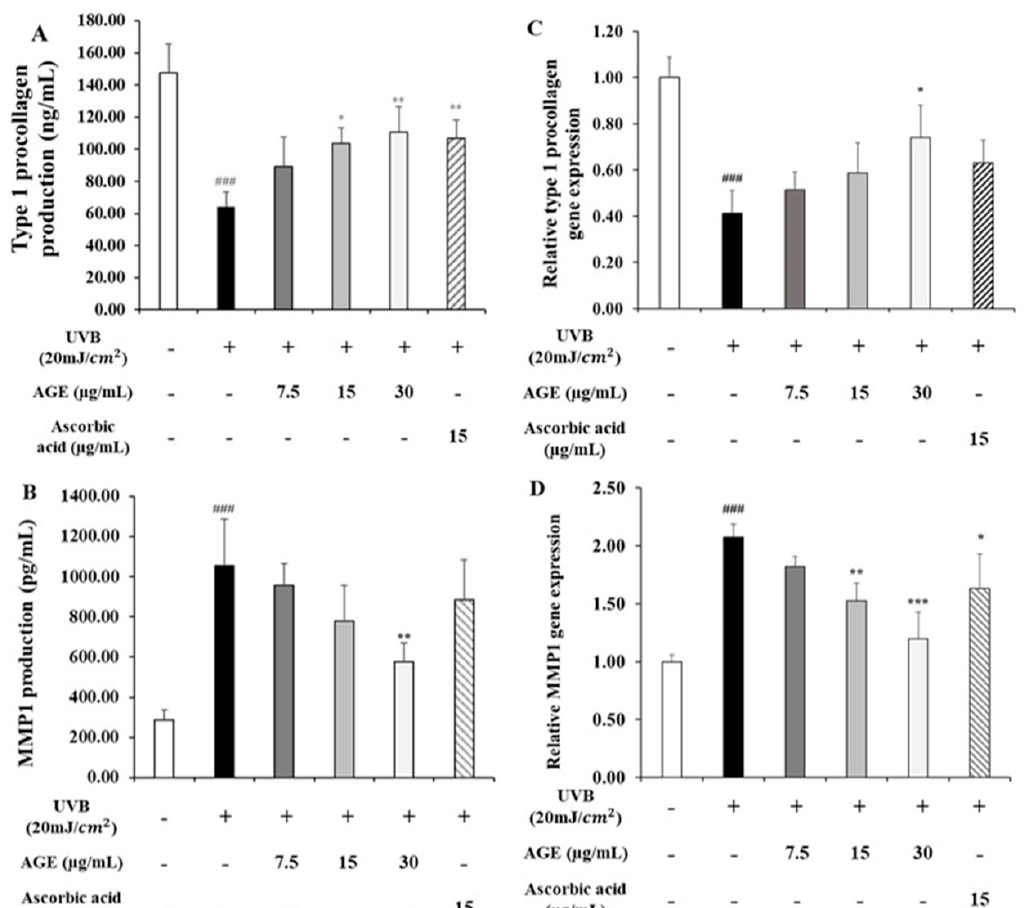
Figure 3. Effect of AGE on type I procollagen and MMP-1 level in UVB-irradiated HDFs. HDFs were irradiated with UVB (20 mJ/cm 2 ), followed by treatment with 7.5, 15, and 30 µ g/mL of AGE. After 24 h of incubation, detection of type I procollagen ( A ) and MMP-1 ( B ) production were performed by using ELISA kits. Gene expression of COL1A1 ( C ) and MMP-1 ( D ) were determined by quantitative real-time (qRT)-PCR. All data were expressed as the mean ± SD of at least three independent experiments. ### p < 0.001 versus untreated cells, * p < 0.05, ** p < 0.01, and *** p < 0.001 versus UVB-irradiated cells.